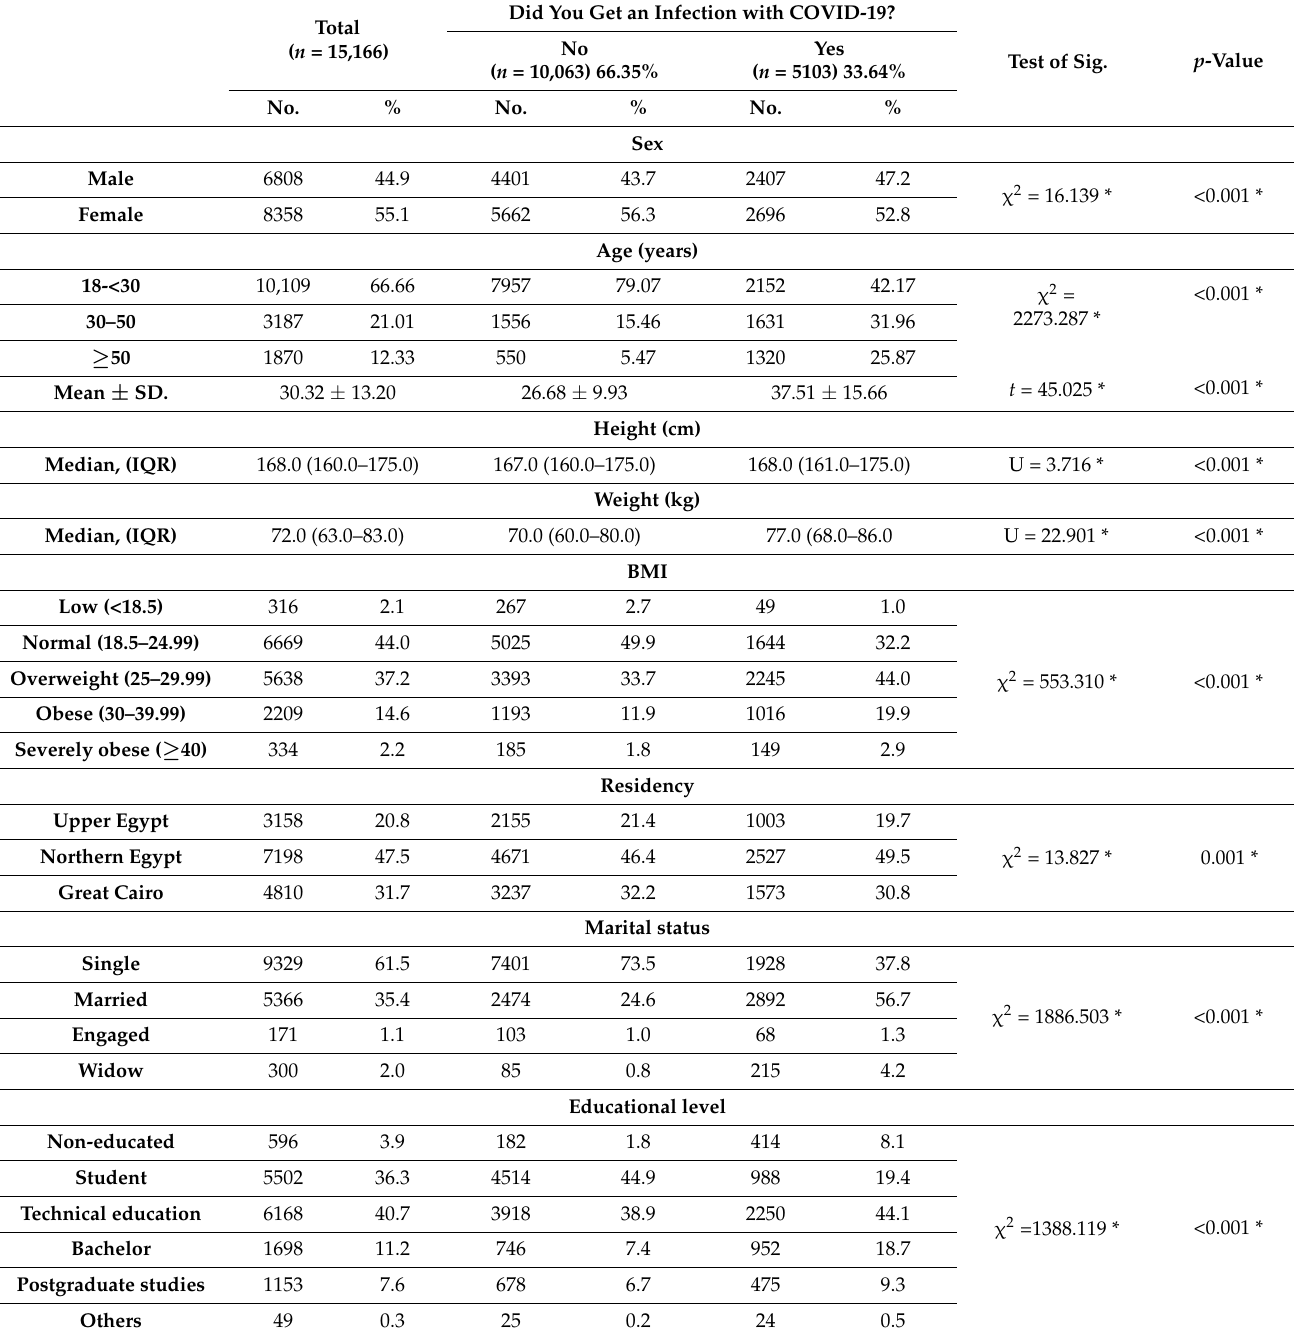
Table 1. The demographic data and the incidence of COVID-19